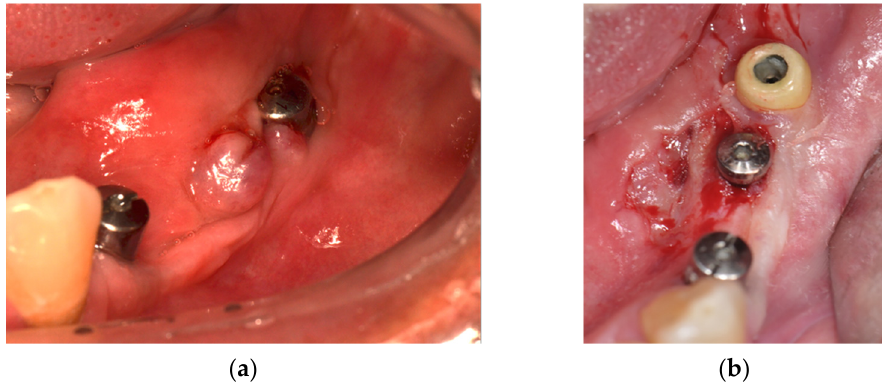
Figure 2. Clinical situation at baseline. ( a ) Intraoral view of the peri-implant lesion after 7 days of